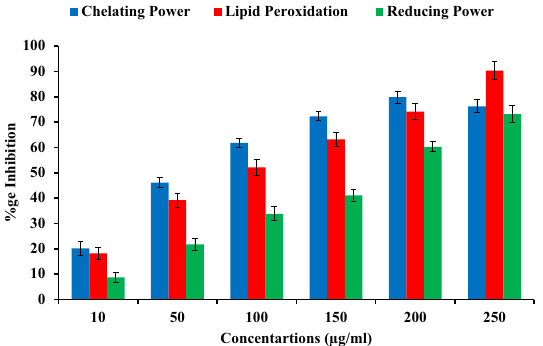
Figure 6. In vitro chelating power, reducing power and lipid peroxidation inhibition of “Betulin” through chelating reducing and Lipid peroxidation assays.